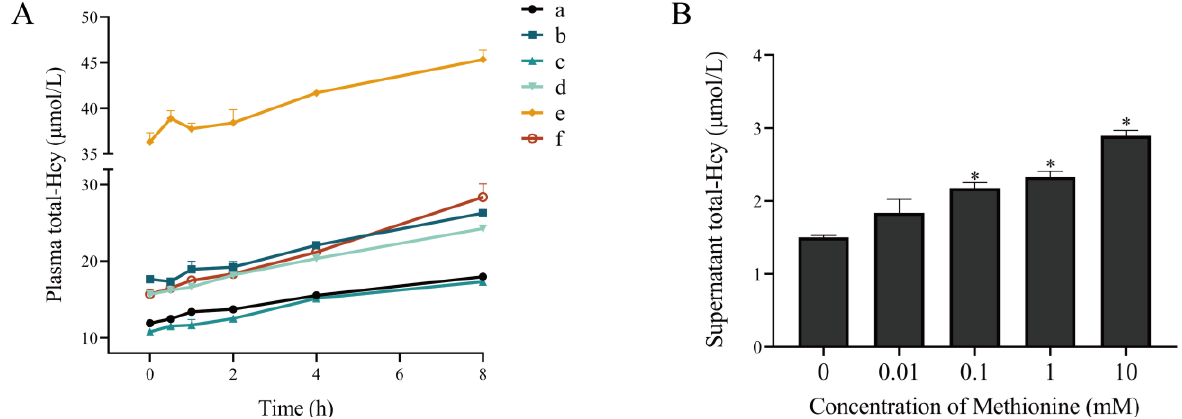
Figure 1. ( A ) The concentrations of plasma total-Hcy after whole blood kept at room temperature for different durations. Plasma total-Hcy content of each whole blood sample (a – f) increased with increasing storage time (0~8 h) at room temperature. ( B ) Effect of methionine on total-Hcy production from erythrocytes. Addition of 0.01~10 mM methionine led to a concentration-dependent increase of total-Hcy in the supernatant. * p < 0.05 vs. 0 mM methionine group.